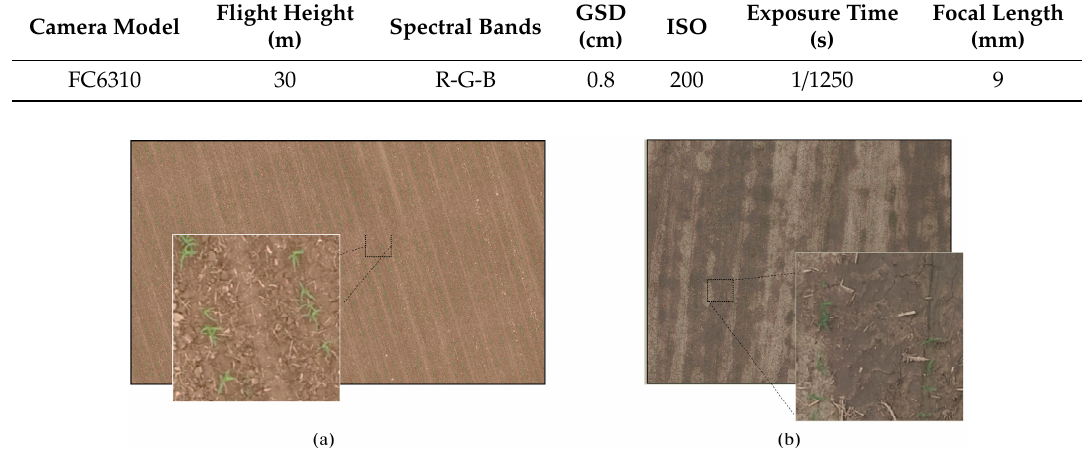
Figure 6. Full view of the investigated datasets: ( a ) First dataset and ( b ) second dataset.